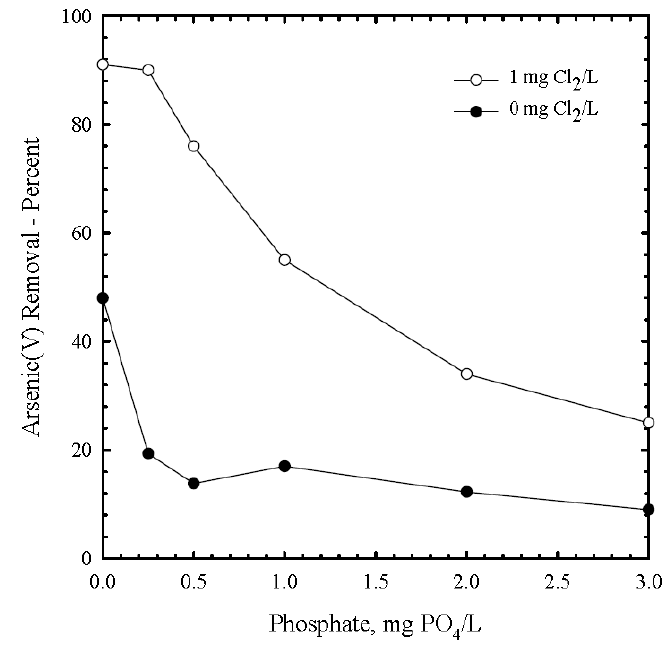
Figure 5. Effect of chlorine and phosphate on arsenic(V) removal with iron(III) (10 mg DIC/L, 1 mg Fe(II) initial, pH = 8, As(V) 100 µg/L [28].